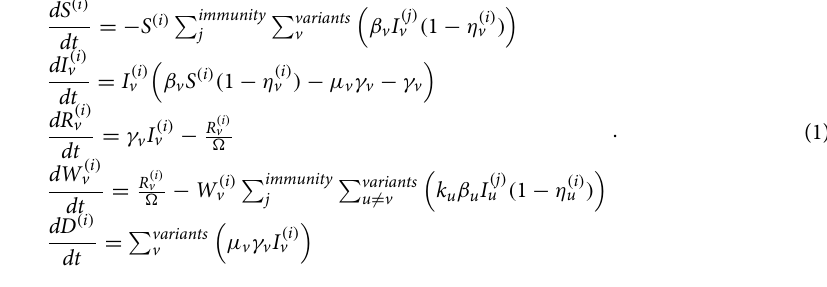
Fig. 1 and can be described by the following equations, with the parameters described in Table 1.